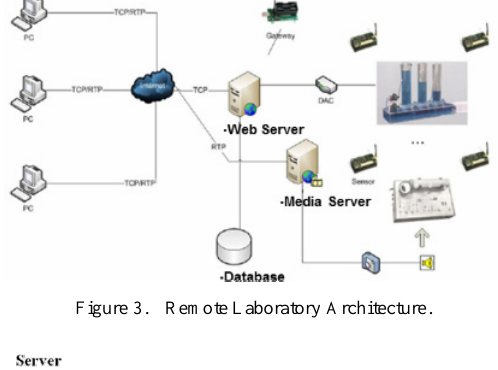
Figure 6. The temperature control process trainer (PT326) used in Experiment 1.